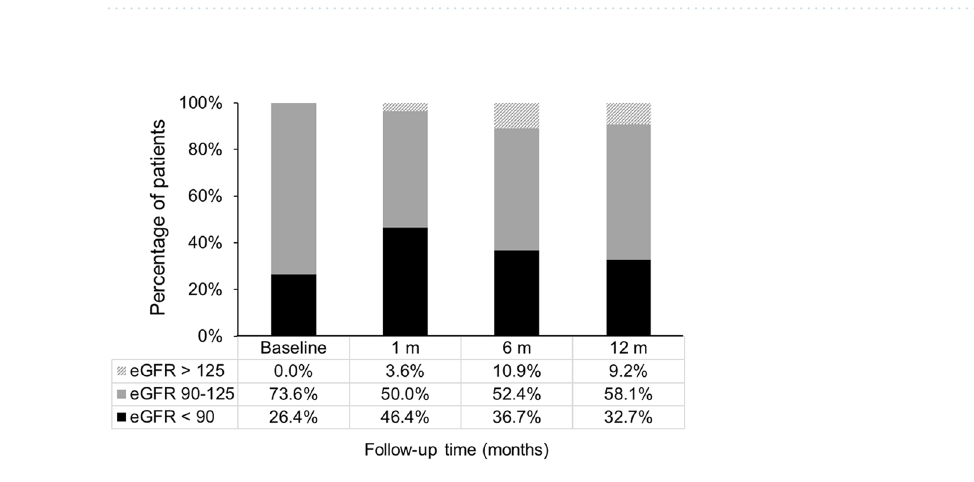
Table 1. Demographic characteristics of patients undergoing laparoscopic sleeve gastrectomy. Data are presented as mean ± standard deviation or as total number of patients (%).